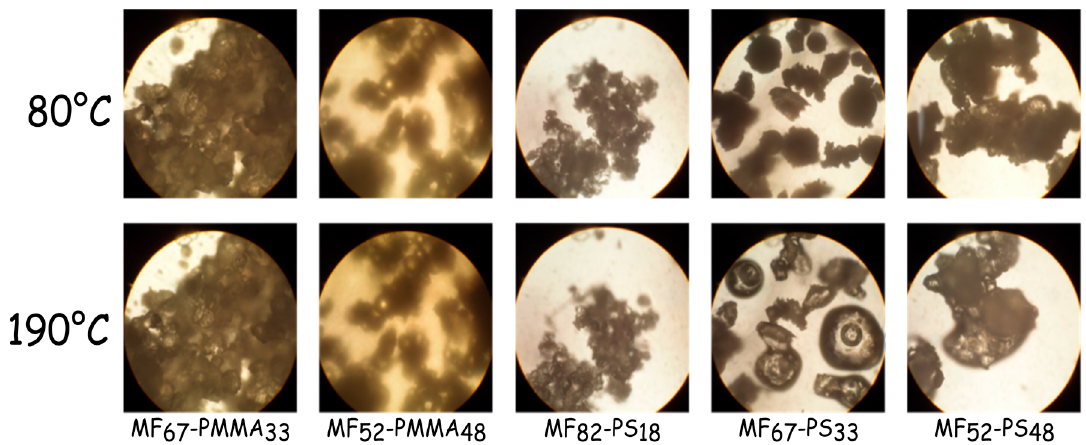
Figure 7. Optical micrographs of microcapsule samples heating with a microscope equipped with a heating plate (at 80 and 190 °C). Table 4. Softening of the microcapsules.